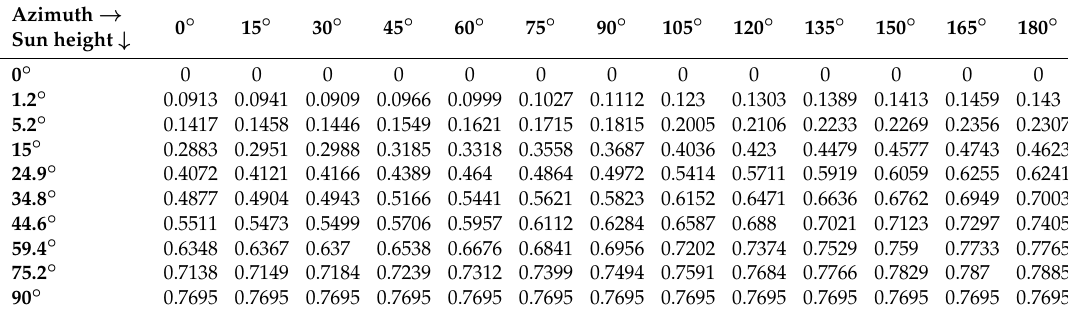
Table A2. Structure of the heliostat field efficiency matrix, as a function of solar elevation angle (vertical axis) and solar azimuth angle (horizontal axis)–example for intercept power 11.5 MWth and latitude 20 ◦ N.